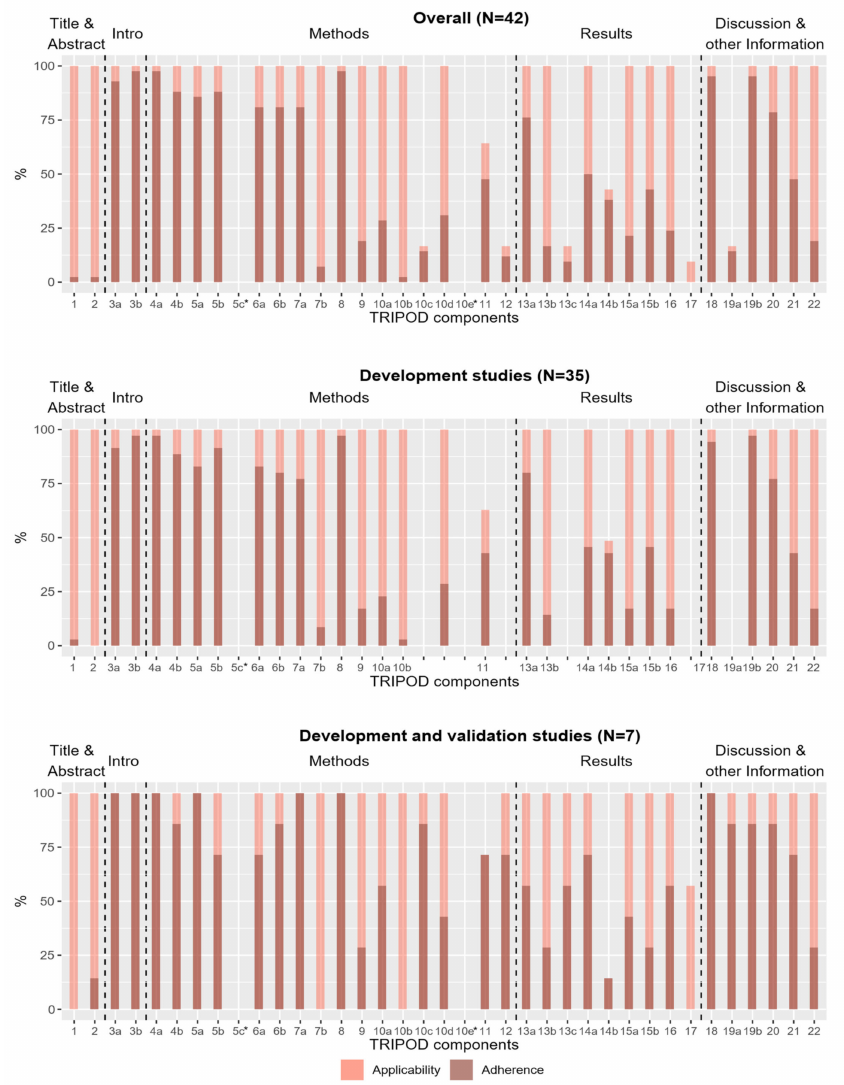
Figure 2. Applicability and reporting of TRIPOD components in the total group of studies (N = 42), in development studies (N = 35) and in development and validation studies (N = 7). Bright bars represent the percentage of studies for which the components were applicable. Dark bars represent the percentage of studies in which the TRIPOD component is fulfilled. * The subitems were rated as “not applicable” in all studies. (Subitem 10e does not apply to development studies, so in this case “all studies” means all development and external validation studies (N =